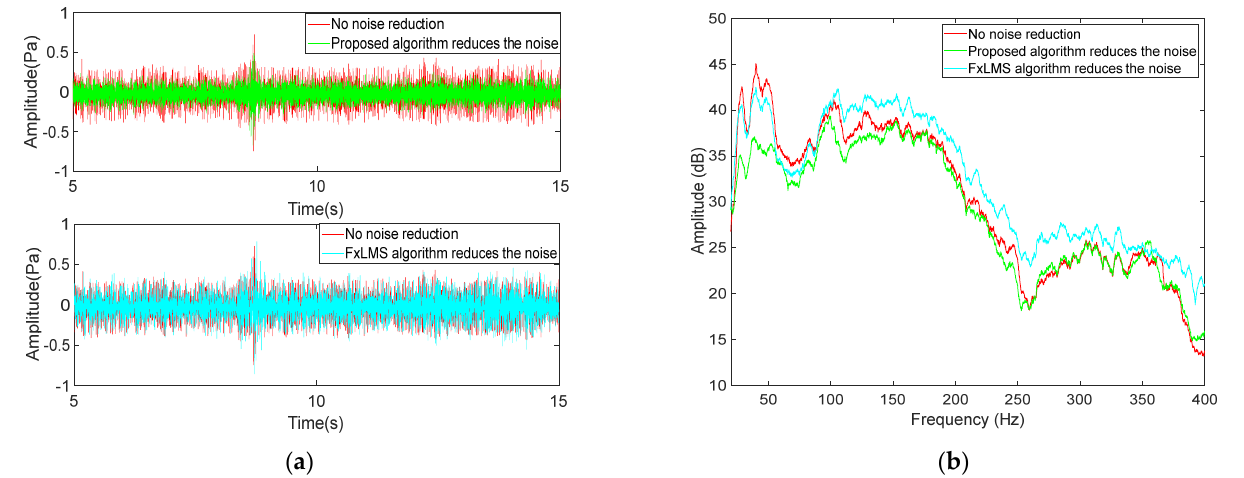
( b ) Figure 14. Experimental noise reduction effect at 30 km/h over a speed bump. ( a ) The time domain, ( b ) The frequency domain. Working condition 2: The car runs at a constant speed of 40 km/h and passes over the speed bump. The experimental results of the vehicle’s internal noise as a reference signal in the second working condition are shown in Figure 15. The time-domain response dia- gram shows that the proposed algorithm significantly reduces the amplitude of sound pressure after noise reduction, but still shows obvious suppression when the noise signal suddenly increases, and the amplitude of the FxLMS algorithm does not change signifi- cantly before and after noise reduction. It can be seen from the frequency response dia-